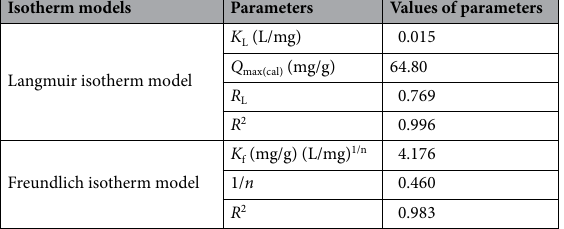
Table 2. The isotherm models and their parameters obtained from the fitting results.